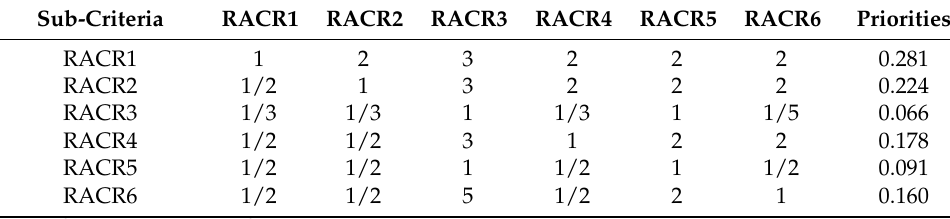
Table 7. Pairwise comparison matrix for the sub-criteria with respect to